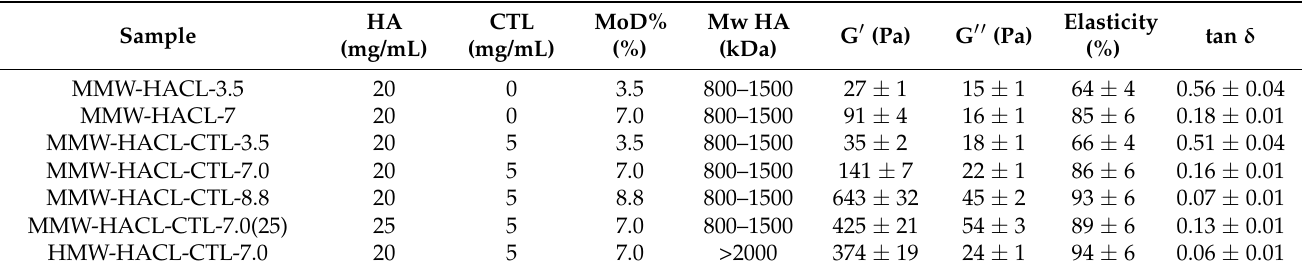
Table 1. Synthetic parameters and viscoelastic results of several samples. * Viscoelastic measurements were performed at a 1